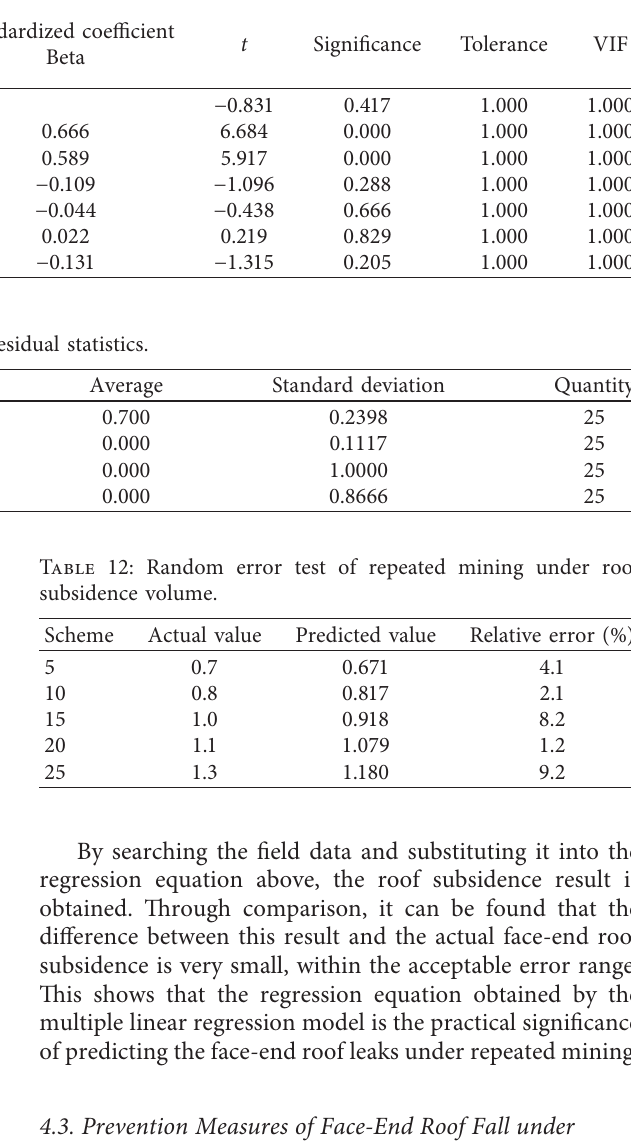
Figure 6: Scatter diagram of the regression normalized residual.